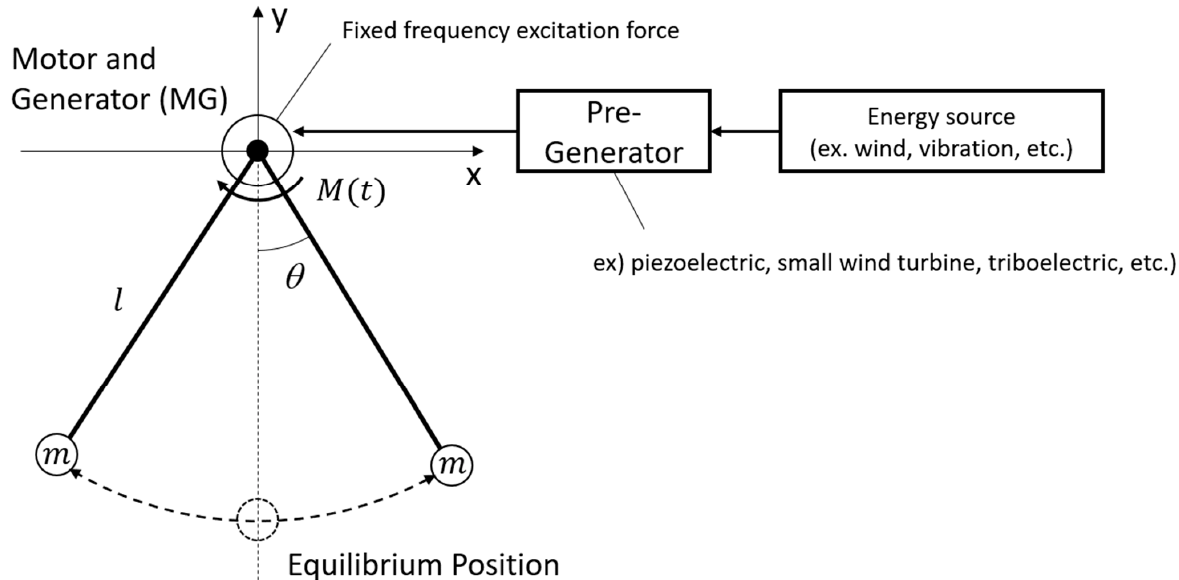
Figure 1. Generator using the resonance of the pendulum model.